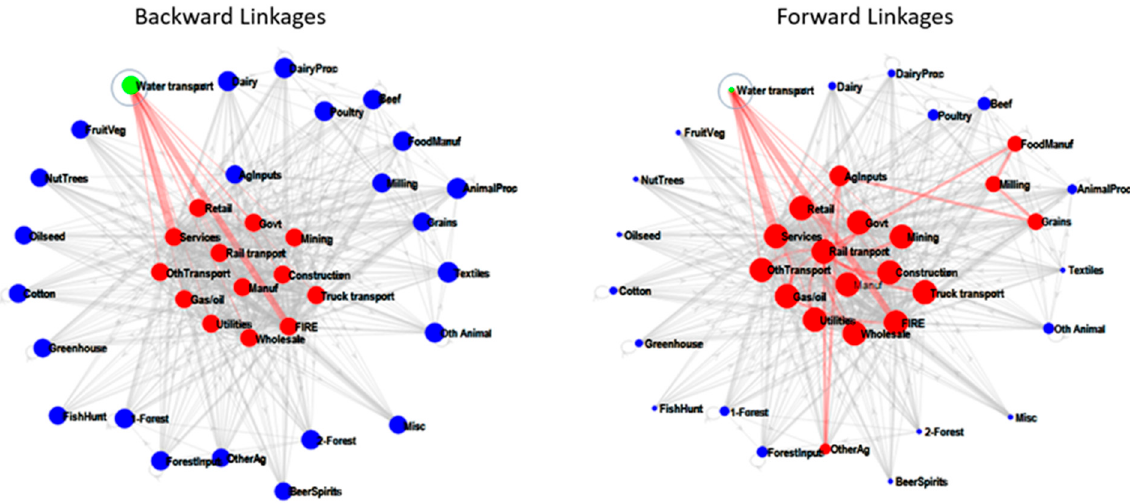
Figure 2. Water transportation backward linkages and forward linkages to other industry sectors in Oklahoma.